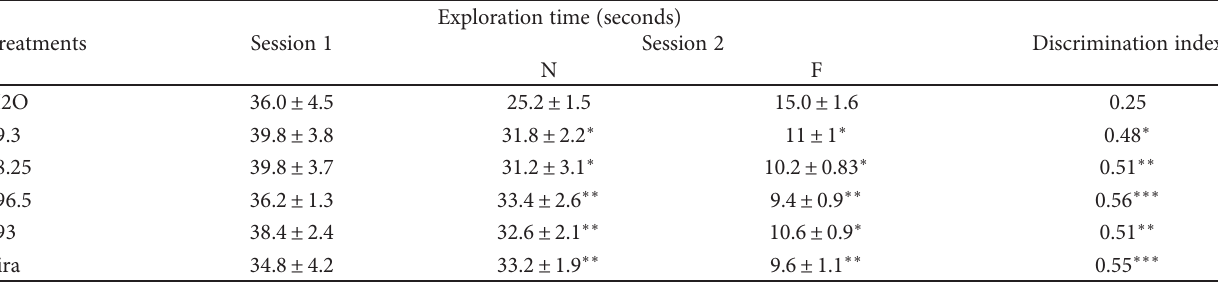
Table 3: E ff ect of M. inermis in normal mice in ORT.